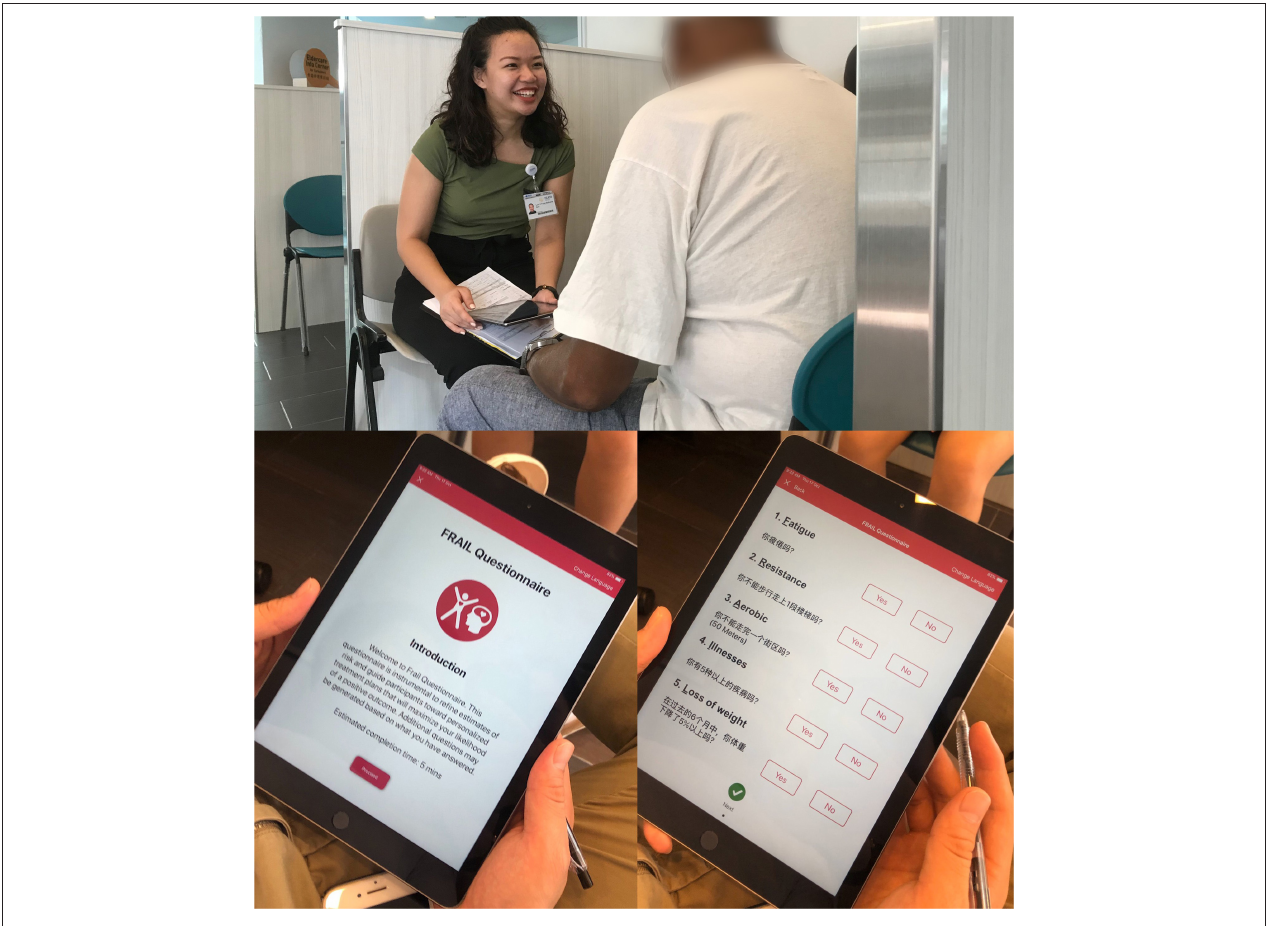
FIGURE 1 | RGA mobile iPad app and